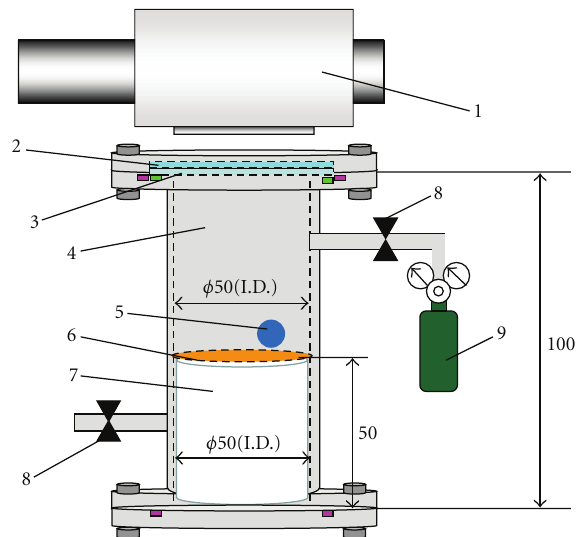
into the stainless pipe, through the coloured glass filter and the quartz glass disc fixed to the top of the stainless pipe. The wavelength of light from Xe lamp is ranged from 185 nm to 2000 nm. The Xe lamp can be fitted with a coloured glass filter to remove UV components of the light. With the filter, the wavelength of light from Xe lamp is ranged from 381 nm to 2000 nm. Figure 3 shows the light transmittance data of the coloured glass filter to prove the removal of the light whose wavelength is below 380 nm. The average